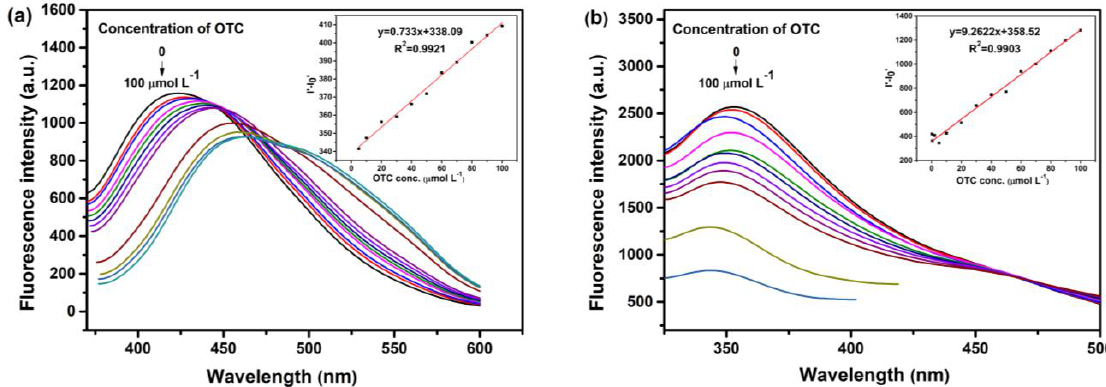
Figure 9. Emission spectra of aqueous N-CQDs dispersion upon addition of various concentrations of OTC. ( a ) ON-CQDs (from top to bottom: 0, 2, 5, 10, 20, 30, 40, 50, 60, 70, 80, 90, and 100 µmol L −1 ); ( b ) WN-CQDs (from top to bottom: 0, 0.25, 0.5, 2, 5, 10, 20, 30, 40, 50, 60, 70, 80, 90, and 100 µmol L −1 ). Inset: calibration curve of fluorescence intensity difference with OTC concentration.